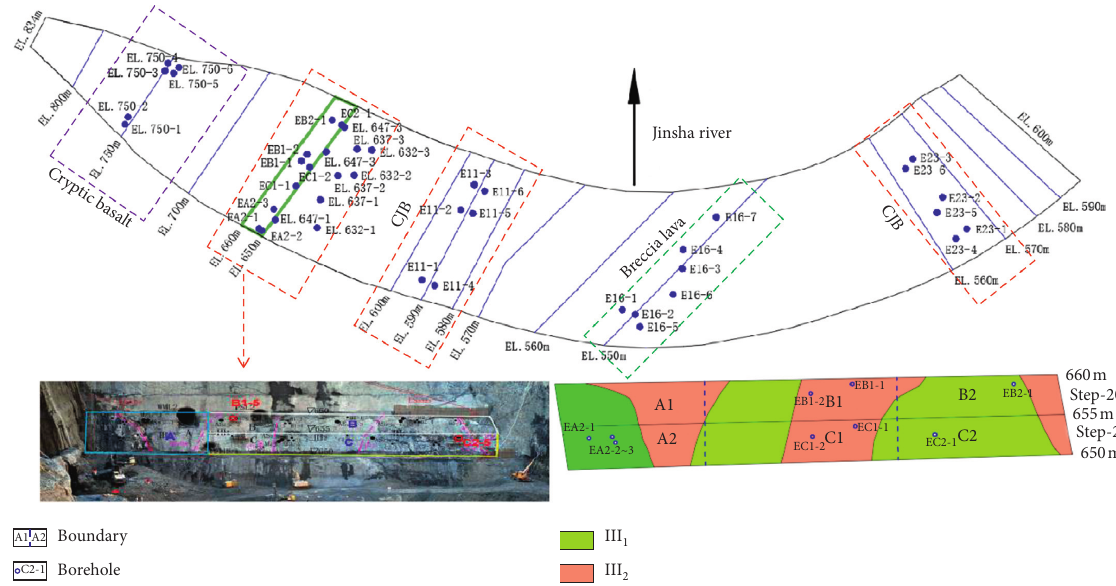
Figure 3: Layout of field testing positions at the dam foundation [18].